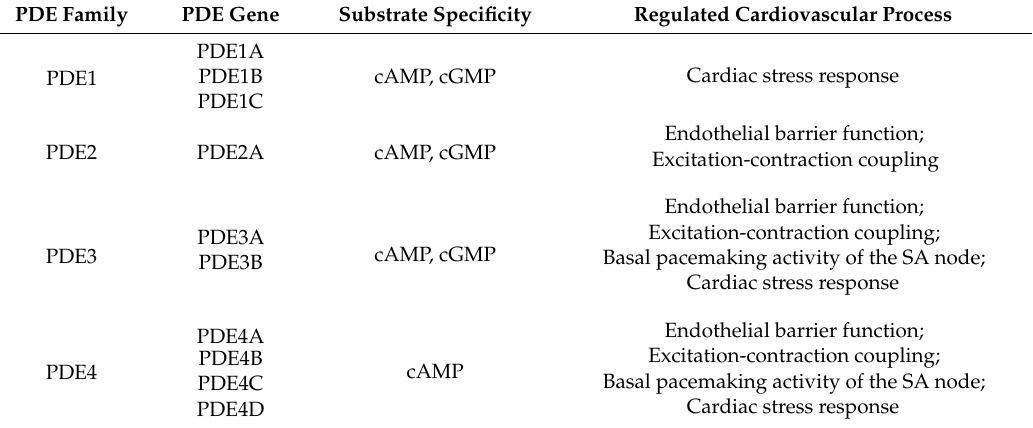
Table 2. Overview of the PDE families expressed in the cardiovascular system and the corresponding cardiovascular processes that they